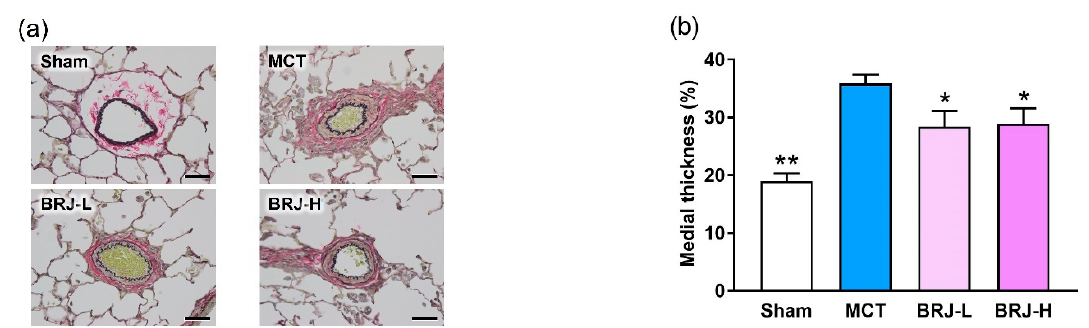
Figure 3. Effects of BRJ supplementation on pulmonary vascular remodeling in MCT-injected rats. ( a ) representative images (scale bar, 50 µm), ( b ) medial thickness. Each column and bar represent the mean ± SEM values of 6–9 experiments. One-way analysis of variance with the Holm–Sidak post hoc test was performed to determine the significance; * p < 0.05 and ** p < 0.01, compared to the MCT group. Abbreviations: BRJ, beetroot juice; MCT, monocrotaline; BRJ-L, low-dose beetroot juice; BRJ-H, high-dose beetroot juice.